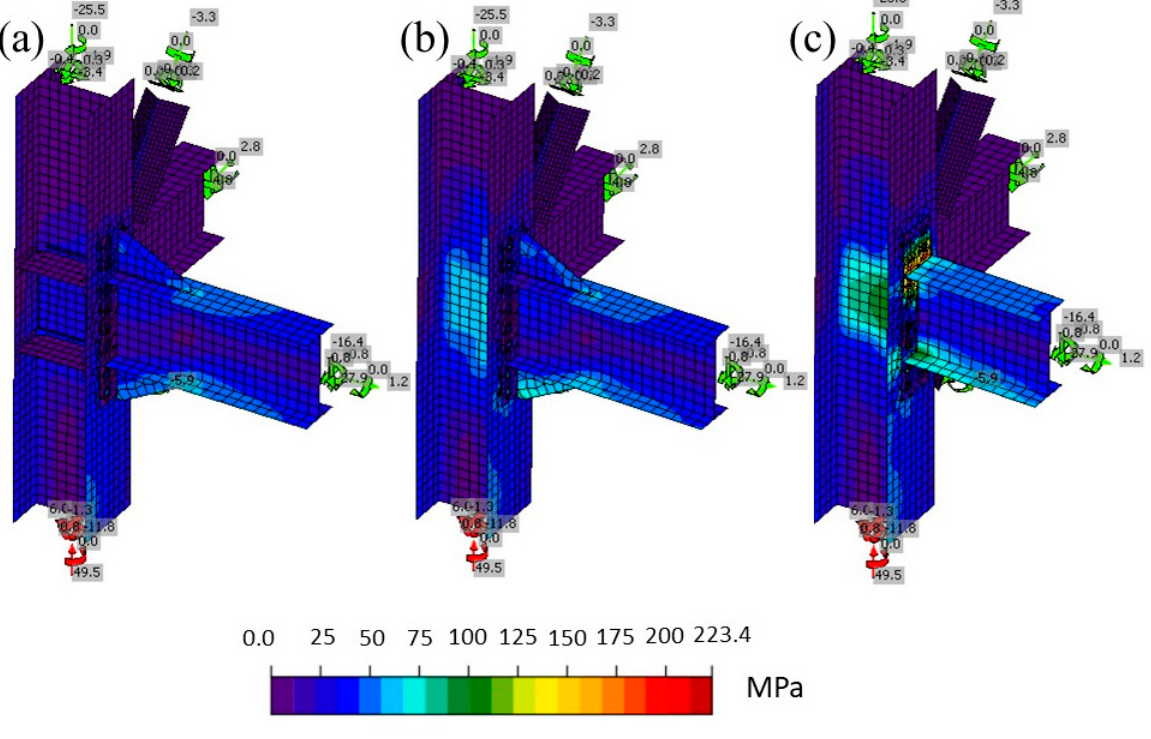
Figure 6. Equivalent stresses computed on the connection for the three 8ES EPC models: ( a ) CP-DP-ST, ( b ) ST, and ( c ) NP.